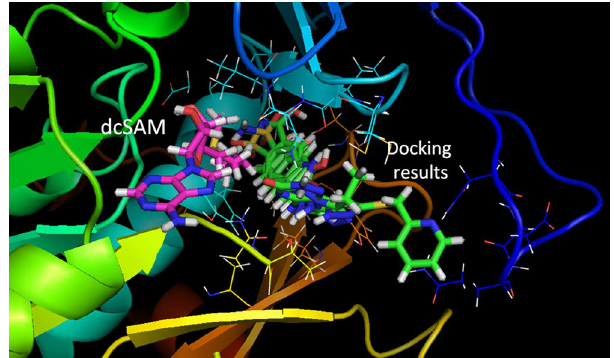
Figure 2. Results of the TcSpdSyn-ligand docking analysis. Docking poses of the top five compounds (green: docking results, pink: dcSAM). This simulation was conducted with the TcSpdSyn X-ray structure (PDB ID code: 3BWC). The docking results show that all compounds bind to the putrescine-binding site and that dcSAM binding in its own